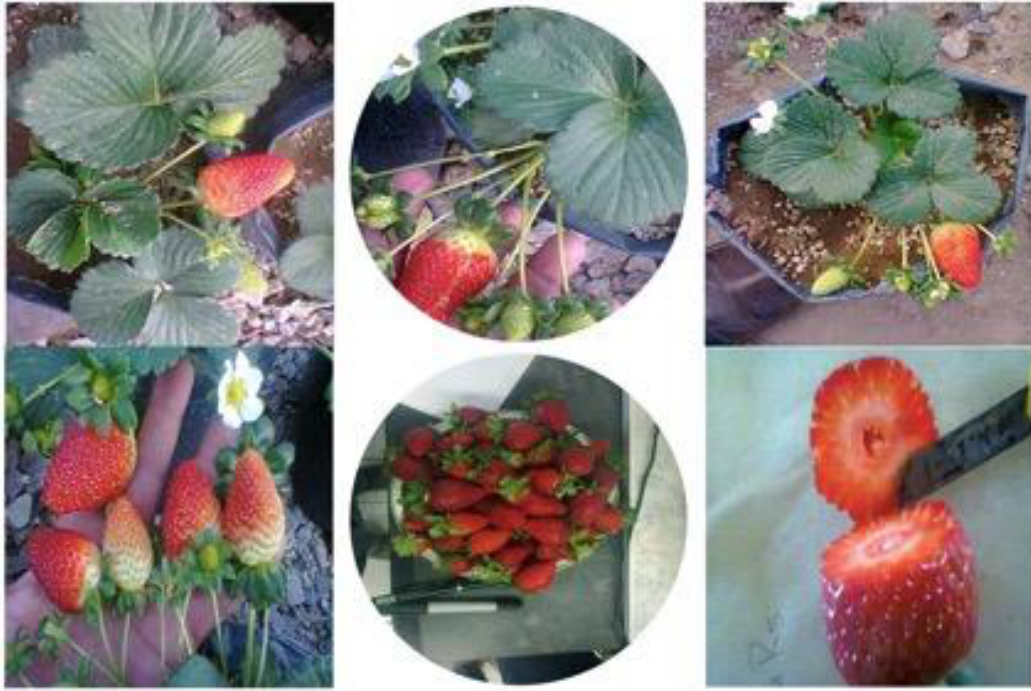
Figure 1. Strawberry grown under soilless conditions with the effects of N / K interaction, northern Mexico.